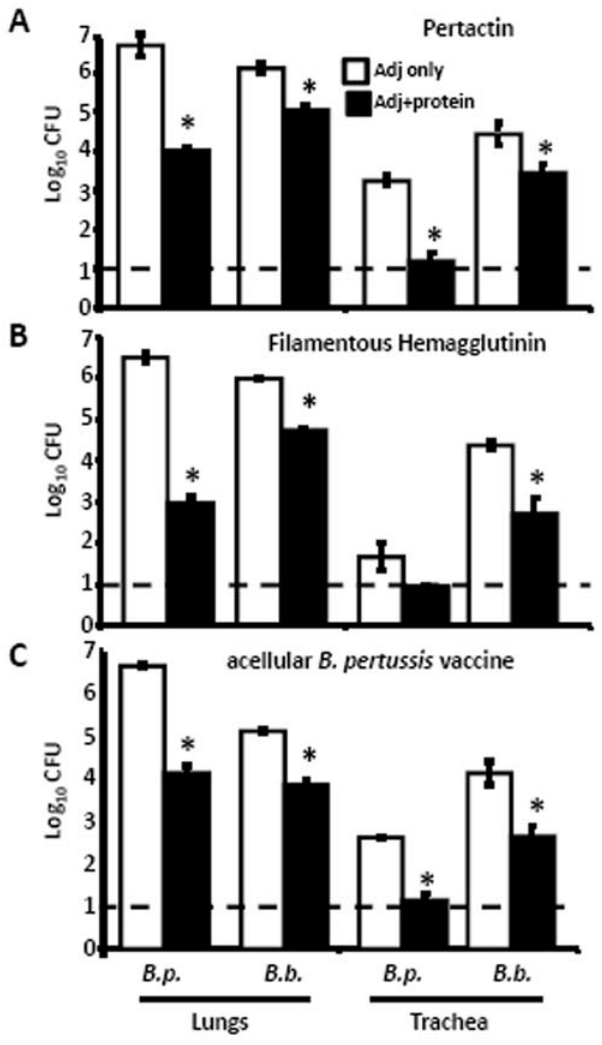
Figure 6. Effect of vaccination with B.pertussis -derived antigens on B.bronchiseptica colonization in the LRT. Groups of 3–4 C57BL/ 6 mice were vaccinated with (A) 40 m g PRN, (B) 5 m g FHA or (C) 0.5 mL of 1:5 dilution of Adacel in PBS and Imject Alum on Days 0 and 14. Adjuvant-only control (white bars) and protein with adjuvant (black bars) vaccinated mice were challenged on Day 28 with B. pertussis ( B. p. ) or B. bronchiseptica ( B. b. ) and dissected Day 3 post-challenge. Bacterial numbers are represented as the mean Log 10 CFU + / 2 SEM. Dashed line indicates the lower limit of detection. * indicates statistical difference ( P value of , 0.05) between adjuvant only and protein with adjuvant treated groups. doi:10.1371/journal.pone.0006778.g006 numbers of both by greater than 99.9% in the lungs and trachea (Figure 7A and B) by Day 3 post-challenge; indicating that immunity to B. pertussis is sufficient to control B. bronchiseptica strains recently isolated from humans.